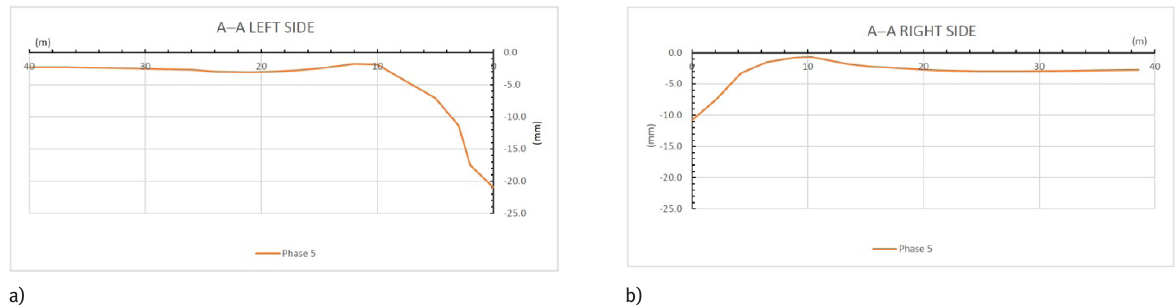
Figure 8: Phase 5 of the implementation – conducting foundation excavation to the full depth; graph of vertical displacements of the land surface in the A–A cross section: a) on the left, b) on the